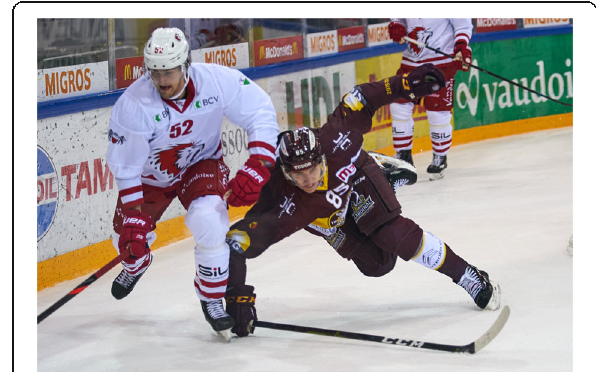
Fig. 6 typical game situation with a collision between two players followed by a crash on ice